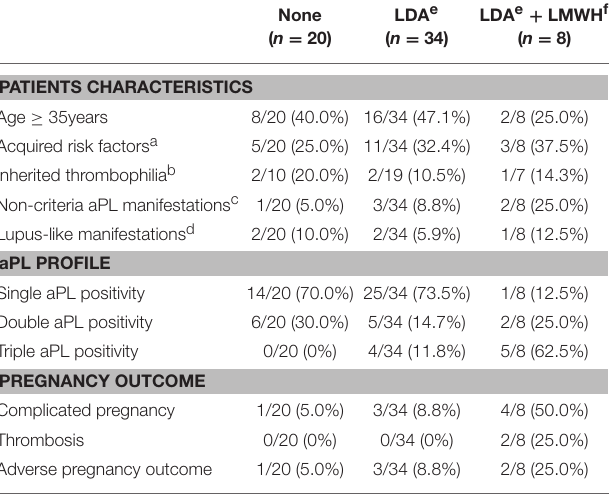
TABLE 4 | Analysis according to the type of treatment received during